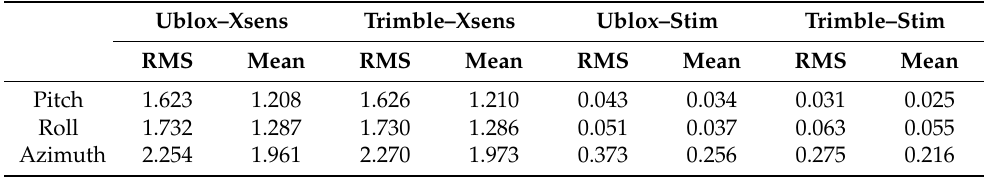
Figure 15. Second field trial: Pitch ( top ), roll ( middle ), and azimuth ( bottom ) of real-time TC GNSS PPP/INS for Ublox– Xsens and Trimble–Xsens solutions. Table 6. RMS error and mean error (deg) of roll, pitch, and azimuth angles—second field